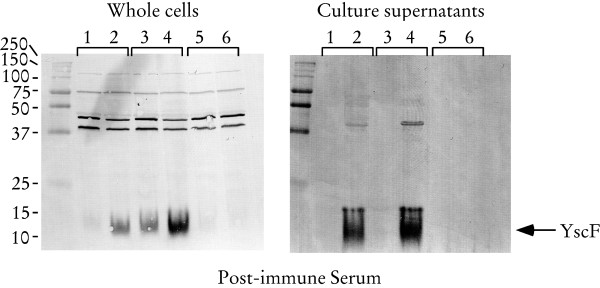
Derivatives of Yersinia pestis KIM8-3002 (KIM5 pPCP1-minus, Smr) were grown in a chemically defined medium at 26°C for 2 h in the presence (lanes 1, 3, and 5) or absence of calcium (lanes 2, 4, and 6). Lanes 1 and 2 contain Y. pestis KIM8-3002. Lanes 3 and 4 contain Y. pestis KIM8-3002 ΔyscF expressing YscF from pBAD18-YscF. Lanes 5 and 6 contain Y. pestis KIM8-3002 ΔyscF gene. After the 2 h growth, the culture was shifted to 37°C to induce expression of the Ysc type III secretion system and the Low Calcium Response. Following 4 h of growth at 37°C cultures, were centrifuged to obtain whole cell fractions and cell-free culture supernatant fractions. Total proteins from each fraction were precipitated with 10% trichloro acetic acid. Dried proteins were resuspended in SDS-PAGE sample buffer and electrophoresed in a 15% SDS-PAGE gel. Proteins were then transferred to a PVDF membrane and immuno-blotted with pooled mouse serum used at a 1:20,000 dilution. Mouse serum was obtained by bleeding mice subsequent to immunization with HT-YscF, serum from several mice was pooled to control for animal specific variation. The position and sizes for the molecular weight markers are indicated and the position of YscF is shown.